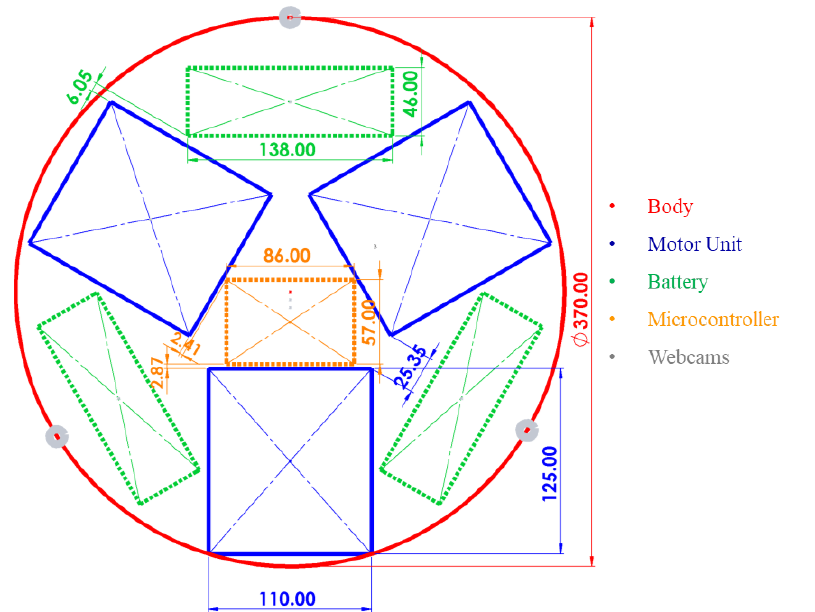
Figure 7. A design scheme of the Torveastro prototype body with inside component location.